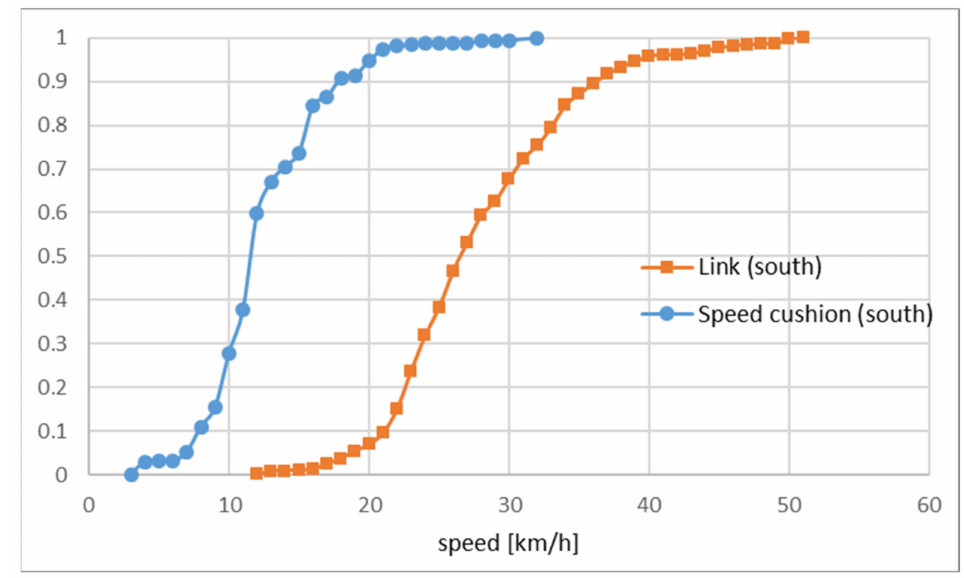
Figure 9. Car speed distributions for the link, direction southbound (orange) and its second speed cushion (blue), source: own.